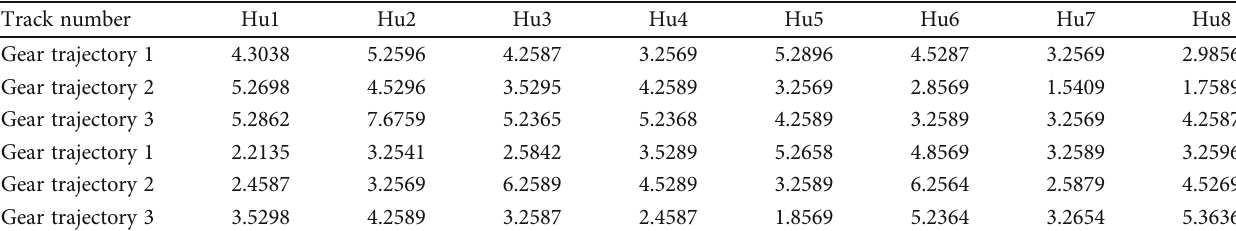
Table 4: Values of Hu1 ~